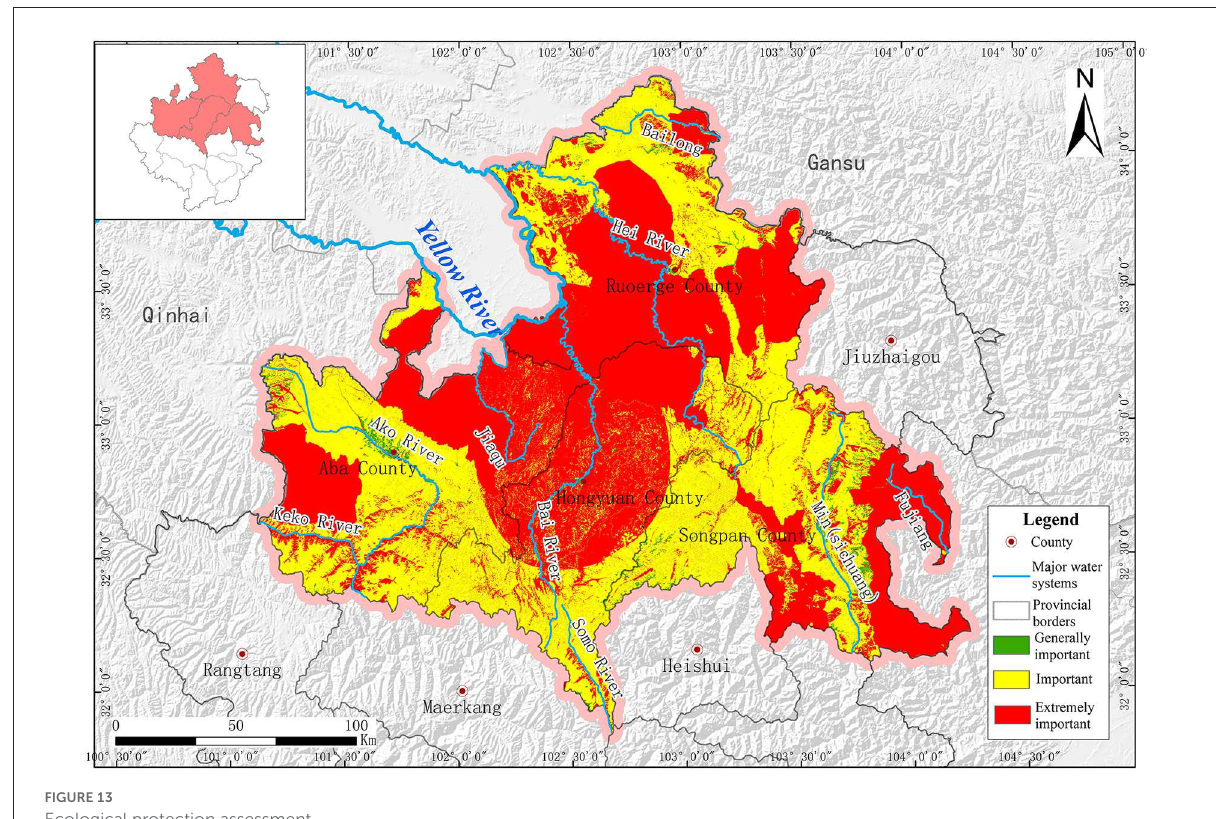
FIGURE13 Ecological protection